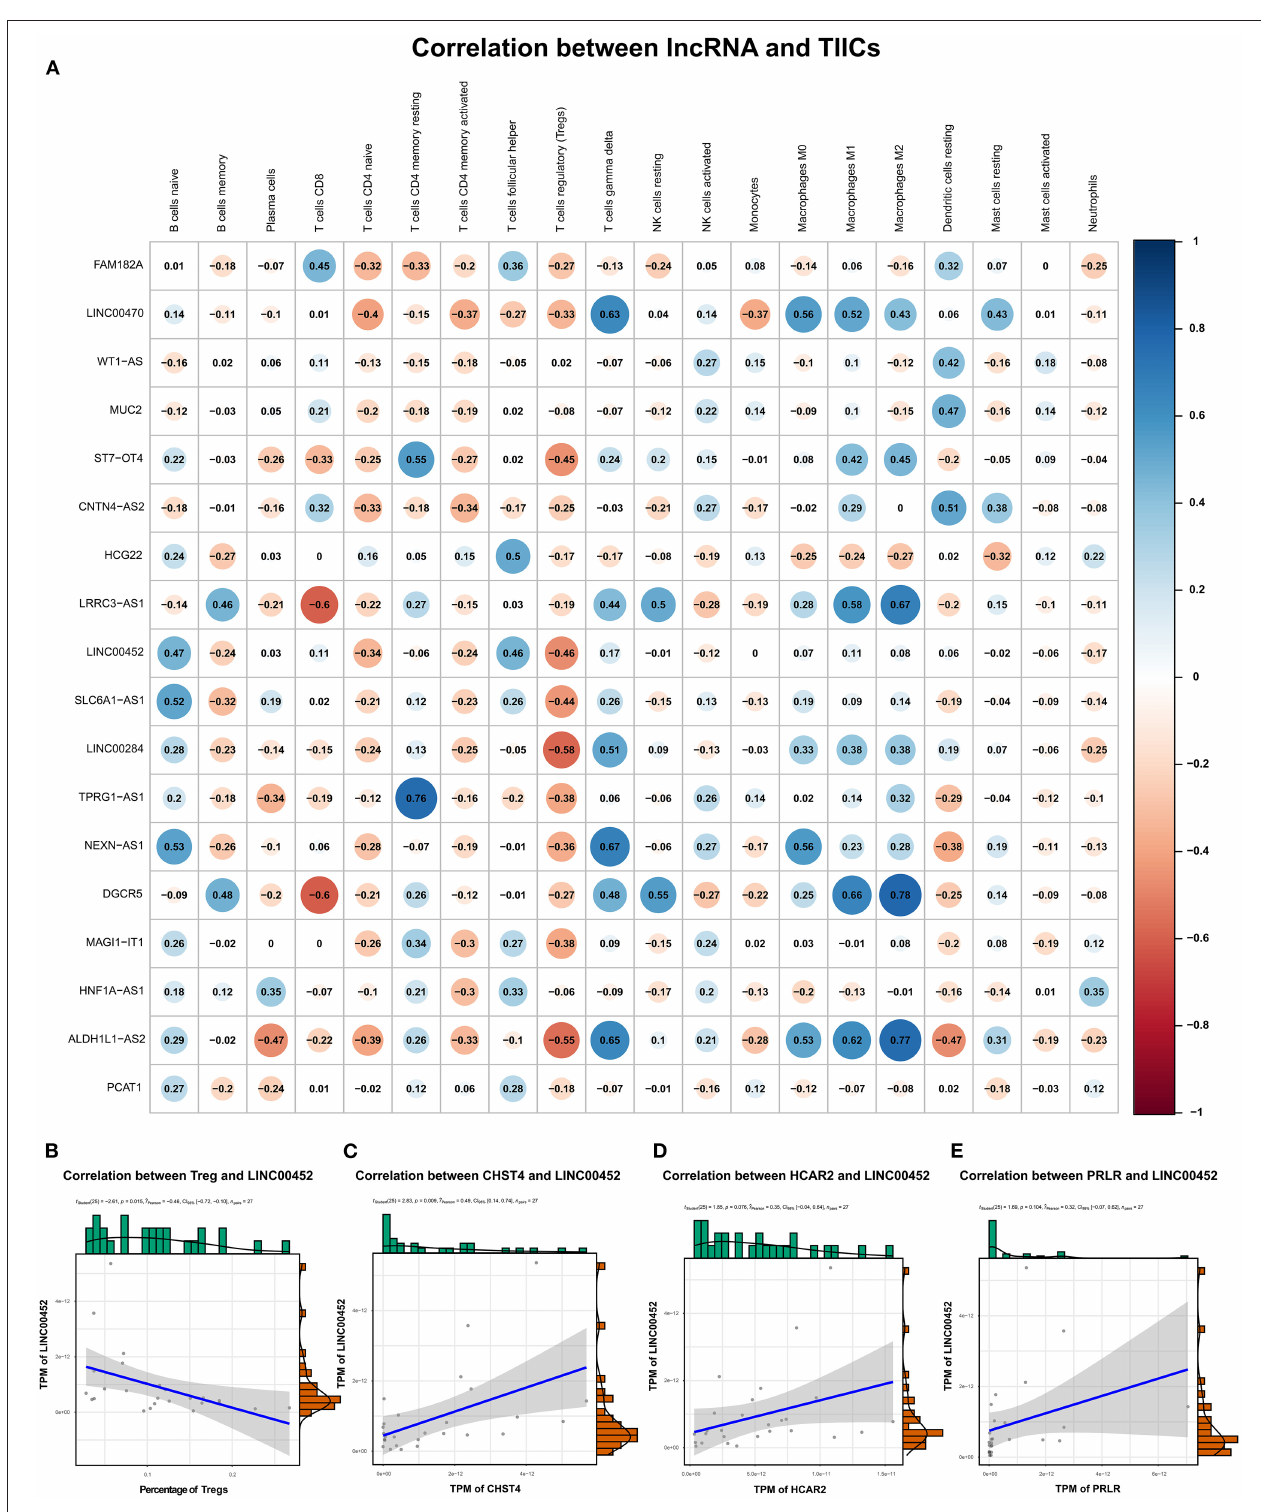
FIGURE 6 | Correlation between lncRNAs in the ceRNA network and estimated immune cells. (A) shows the Pearson correlation coefficient between lncRNAs in the ceRNA network and immune cells. (B) demonstrates the correlation between LINC00452 and Tregs ( r = − 0.46, p = 0.015); (C) shows the correlation between LINC00452 and CHST4 ( r = 0.49, p = 8.953 × 10 − 3 ); (D) denotes the correlation between LINC00452 and HCAR2 ( r = 0.35, p = 0.076); (E) shows the correlation between LINC00452 and PRLR ( r = 0.32, p = 0.104). In (B) , the blue line denotes a linear mode indicating the relation between mRNA expression (TPM value) and the percentage of Tregs. In (C–E) , the blue line denotes a linear mode indicating the relationship between mRNA and lncRNA expression (TPM value). The gray area represents the 95% confidence interval.